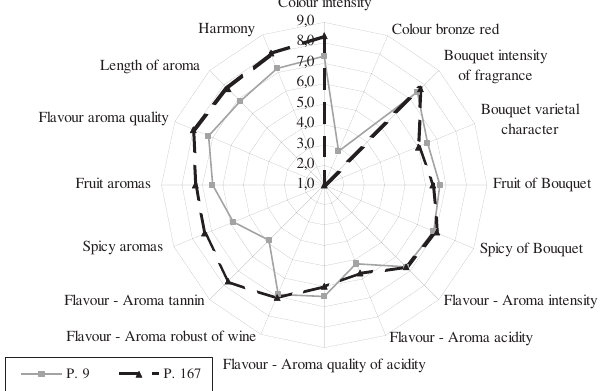
Figure 9. Evaluation of the profile analysis of the wine of the 2011 vintage produced from the P. 167 clone of ‘Kadarka’ (Szekszárd – Batti